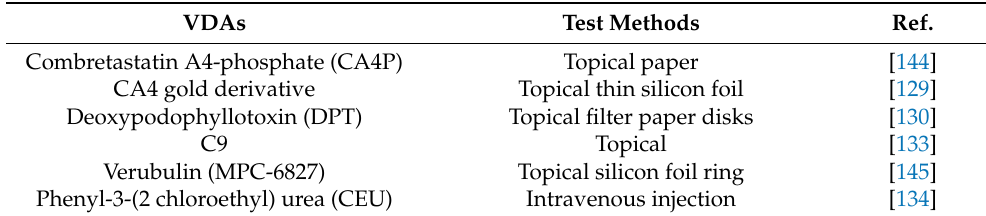
Table 7. Studies of VDAs on the CAM. VDAs Test Methods Ref. Combretastatin A4-phosphate